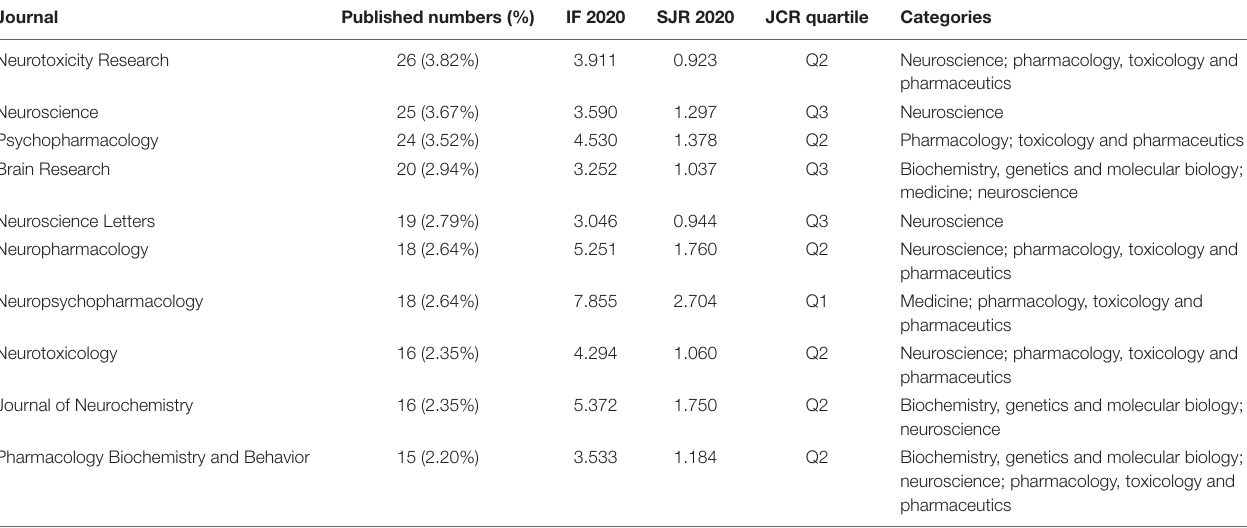
TABLE 3 | The 10 most active journals that published articles on substance abuse and its neurotoxicity